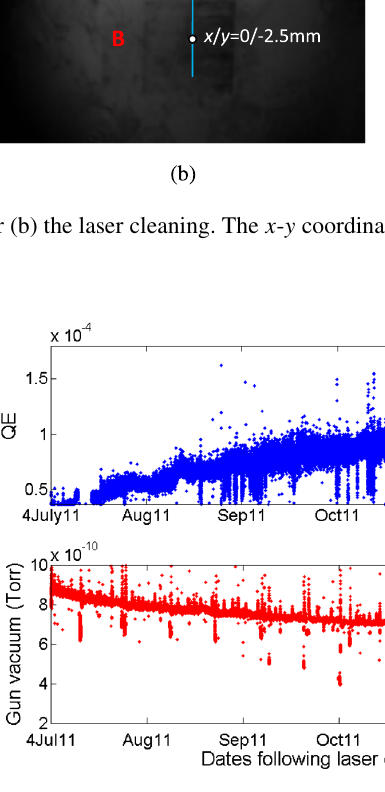
FIG. 4. Evolution of the QE (top) and gun-waveguide vacuum (bottom) during the five months following the laser cleaning, for the cathode spot with yellow